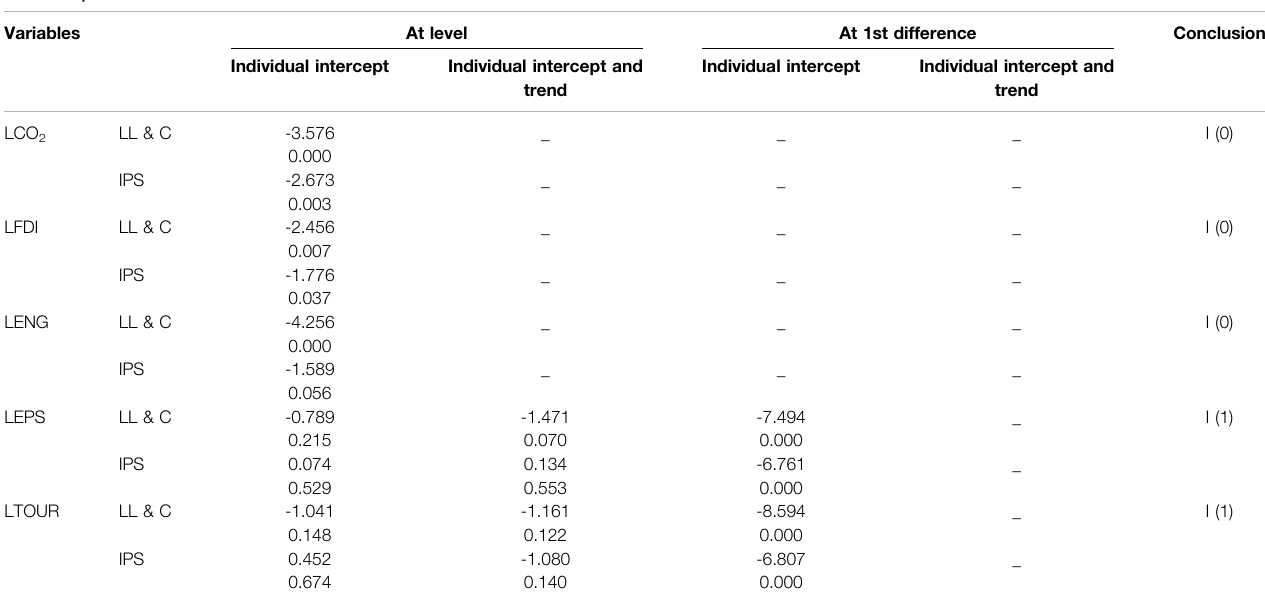
TABLE 2 | Results of unit root tests.